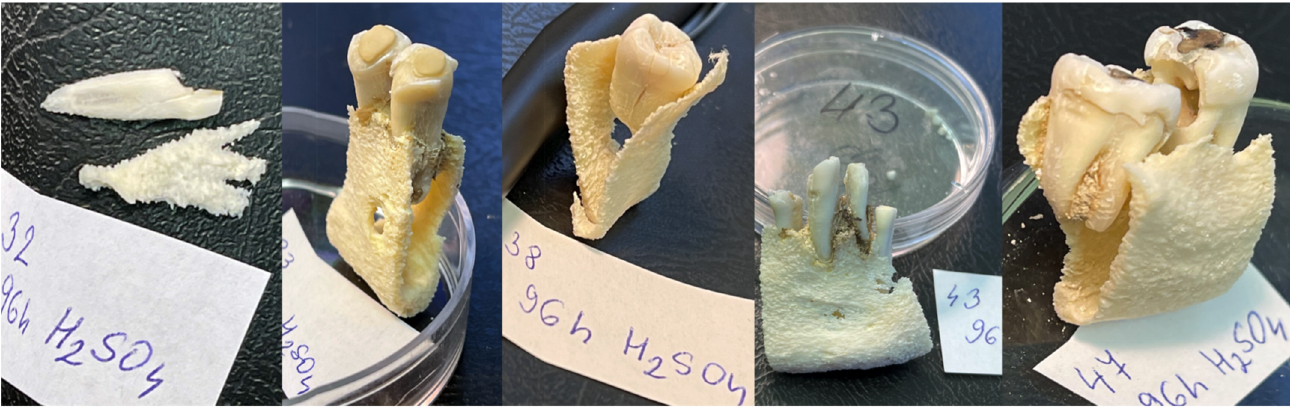
Figure A2. Photo-documentation of the samples after 96 h in 75% sulfuric acid bath.